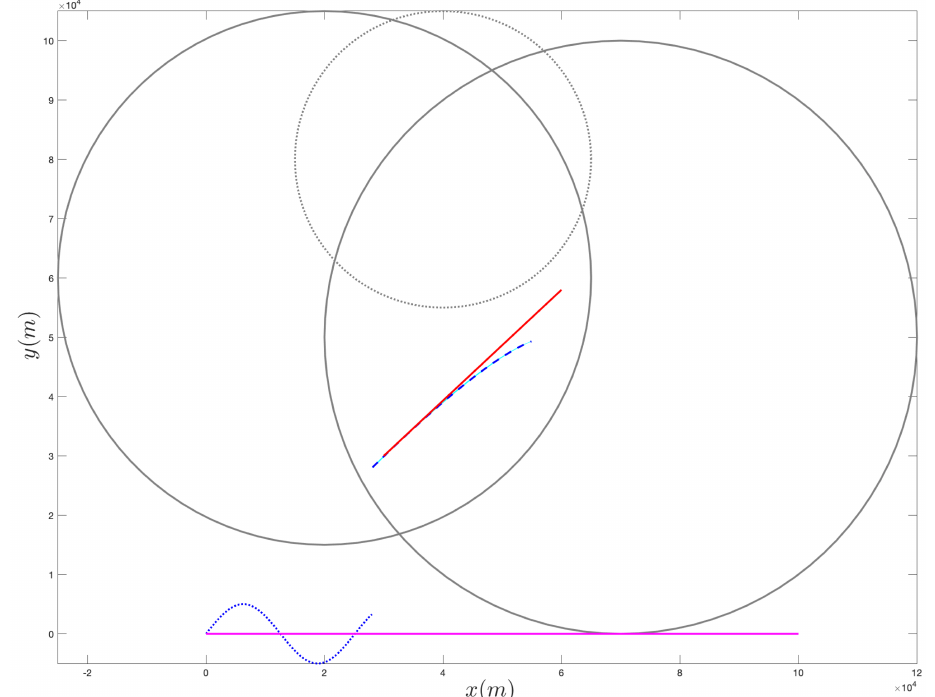
Figure 9. Sampling of 100 trajectories (cyan) based on the best solution found via for the constrained case, but without relying on the APF, and on the CRLB covariance